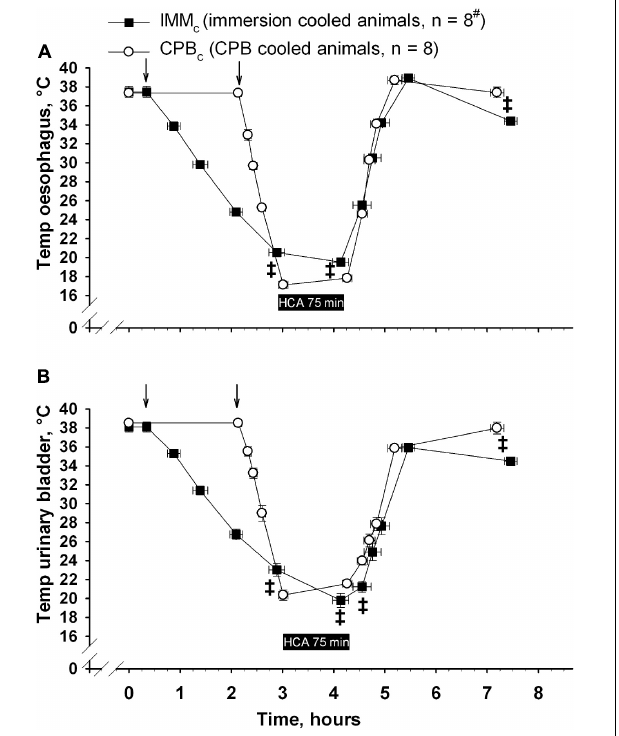
FIGURE 2 | Time-dependent changes in temperature in esophagus (A) and urinary bladder (B) . ↓ denotes start of cooling in either group. Data presented as mean and SEM. ‡ Statistically significant difference between groups ( p < 0.05). # n was reduced to 4 animals at end of the experiments (End exp.) in IMM c